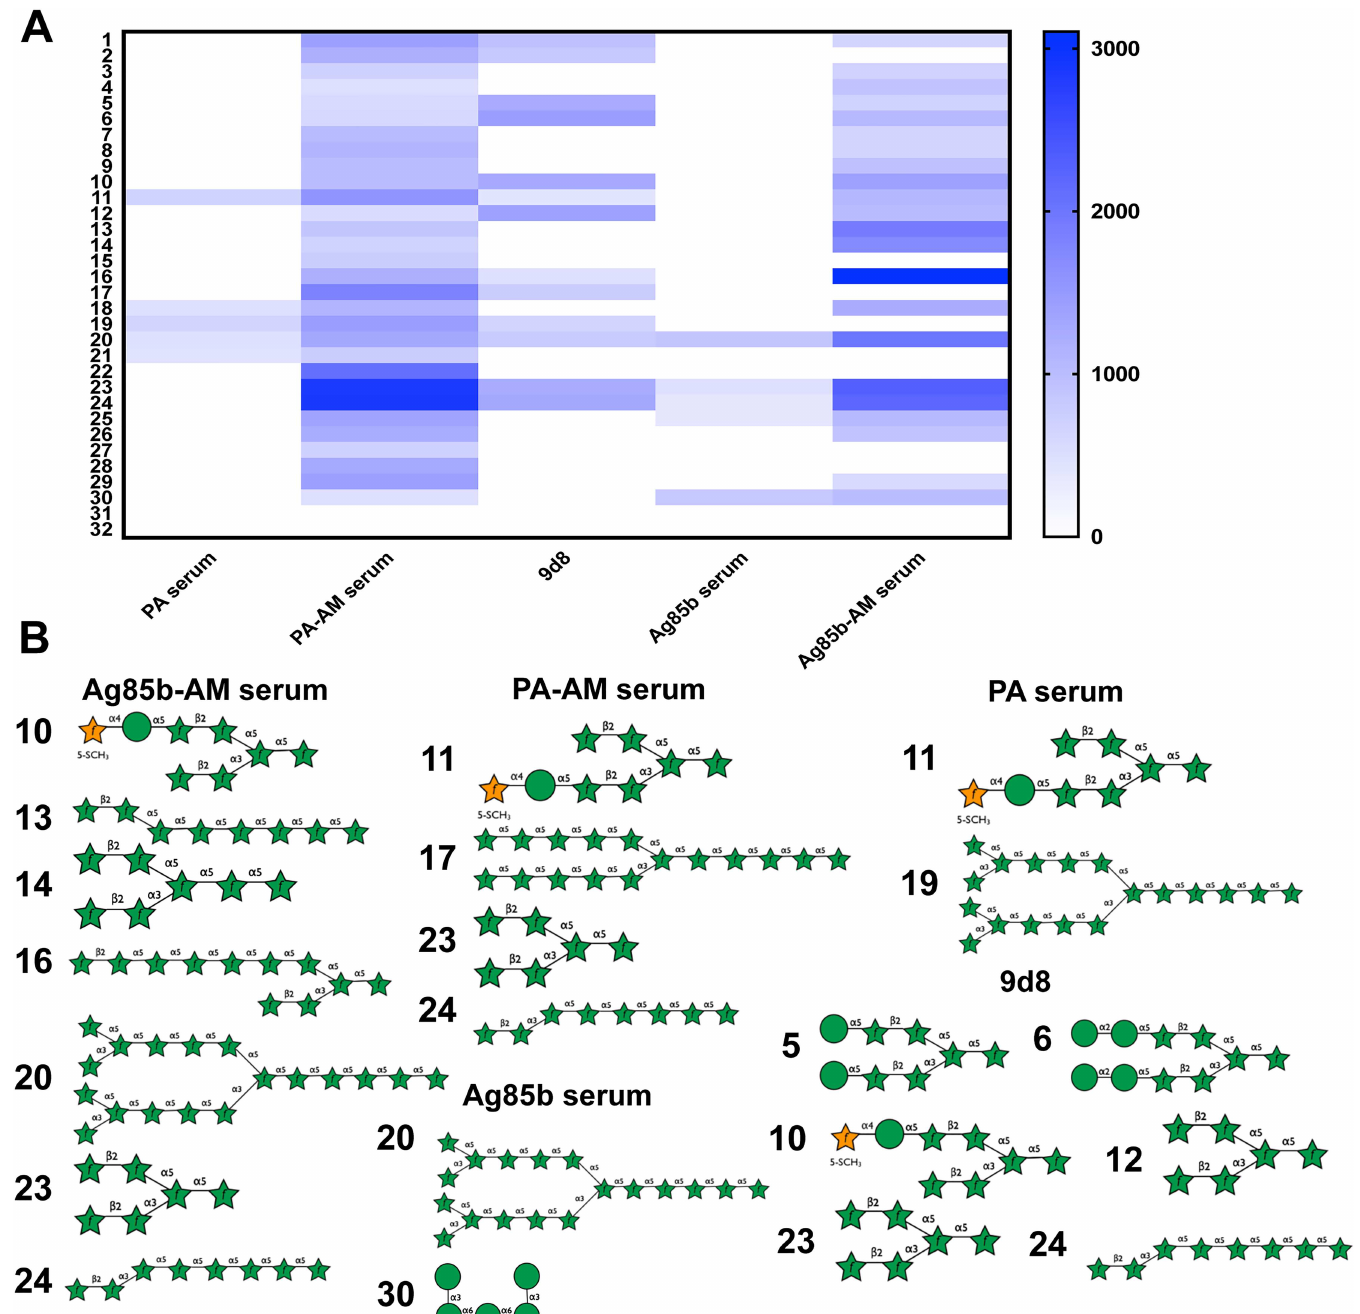
Fig 2. Assessment of the relative IgG-binding of AM immune serathe 29 printed AM fragments. (A) Heat mapof AM glycanmicroarray data obtained after incubationwithpooledmurinesera diluted1:400 followedby labeledanti-IgG. Data are meanof three independentspots. Valuesare relativefluorescence units. (B) AM fragments included in the glycanmicroarray representingthe AM moleculerecognizedby the indicatedserum. The numberscorrespond to those in A andS6 Fig.